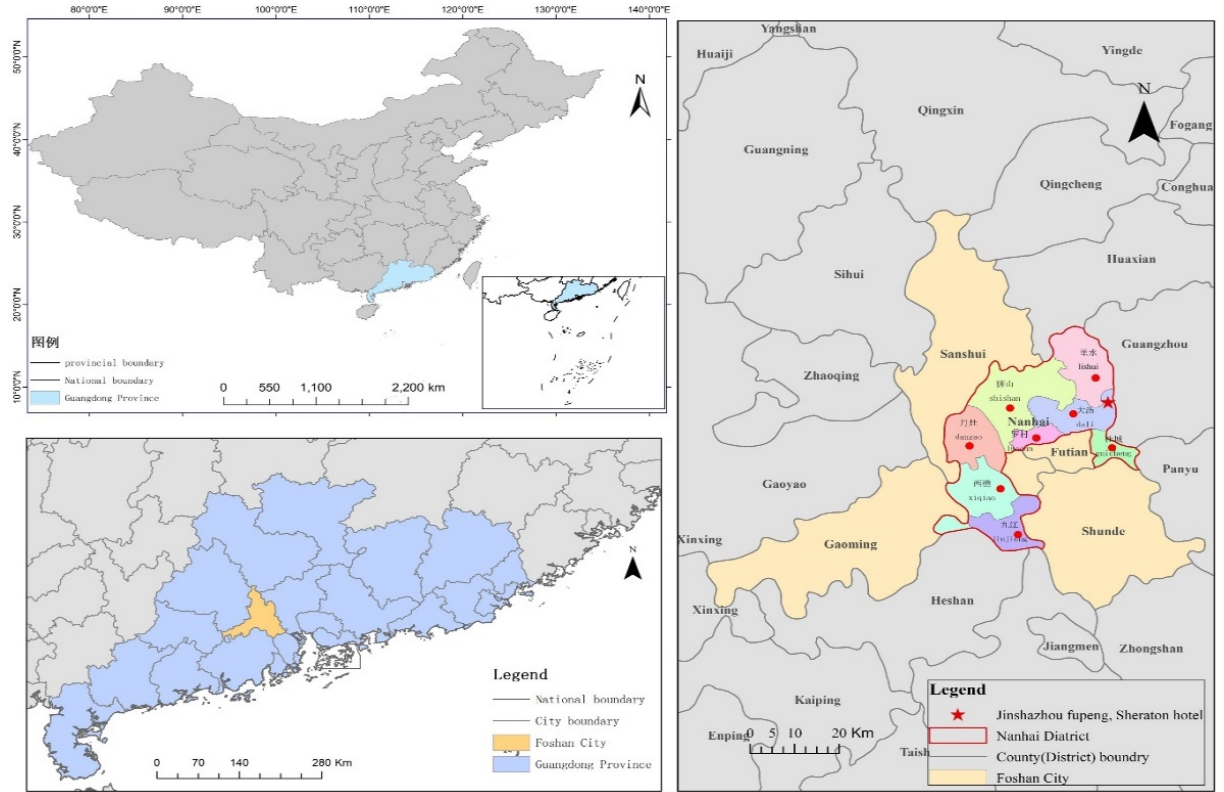
Figure 2. Location of the study area.